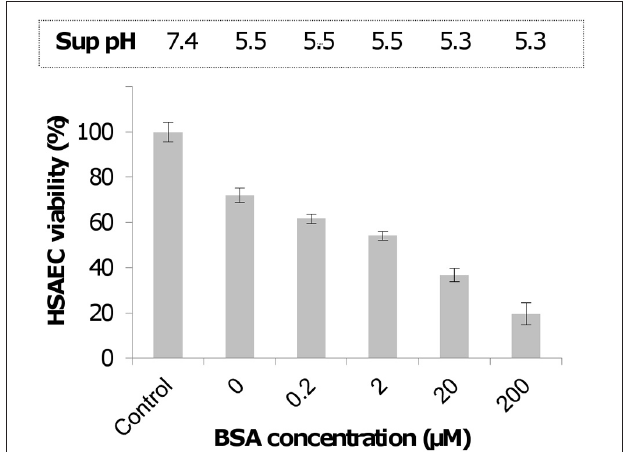
FIGURE 2 | Supplementation of complete DMEM/F12 culture medium with BSA increases the toxicity of Sups of dSterne cultures grown in microaerobic conditions for 24h. HSAECs were exposed to Sups for 2h. Untreated cells served as control. OD 600 of Sups was measured in 96-well plate reader (200 μ l per well). Error bars indicate 95% confidence